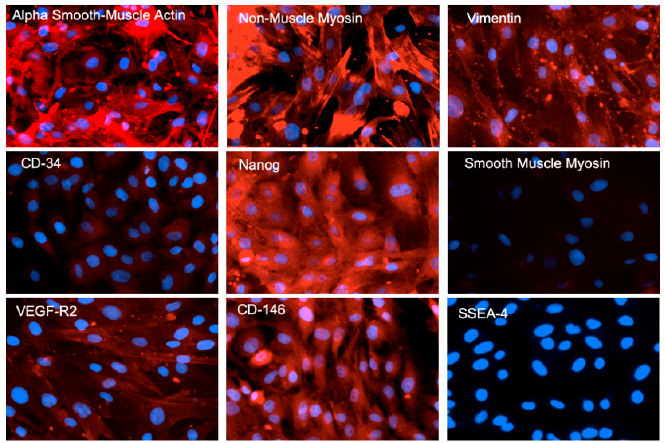
Figure 3. The immune-staining of various markers in fetal VSC. The cell-specific markers were examined using a red fluorescent protein (RFP)-tagged antibody (red fluorescence) against a particular antigen. The red color in Figure 1 indicates the presence of a particular marker, and the blue stain indicates the binding of DAPI dye to the nuclear DNA. All of the images shown in the figure were taken at 10 × magnification.